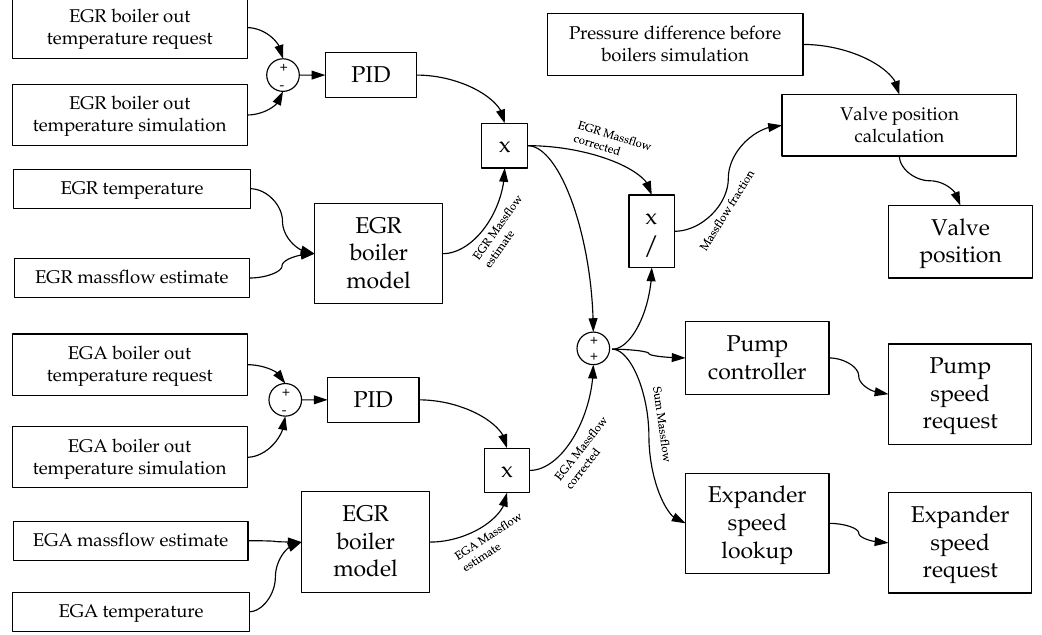
Figure 11. Simplified control strategy flow chart (vapor cycle only). PID: proportional-integral-derivative controller.